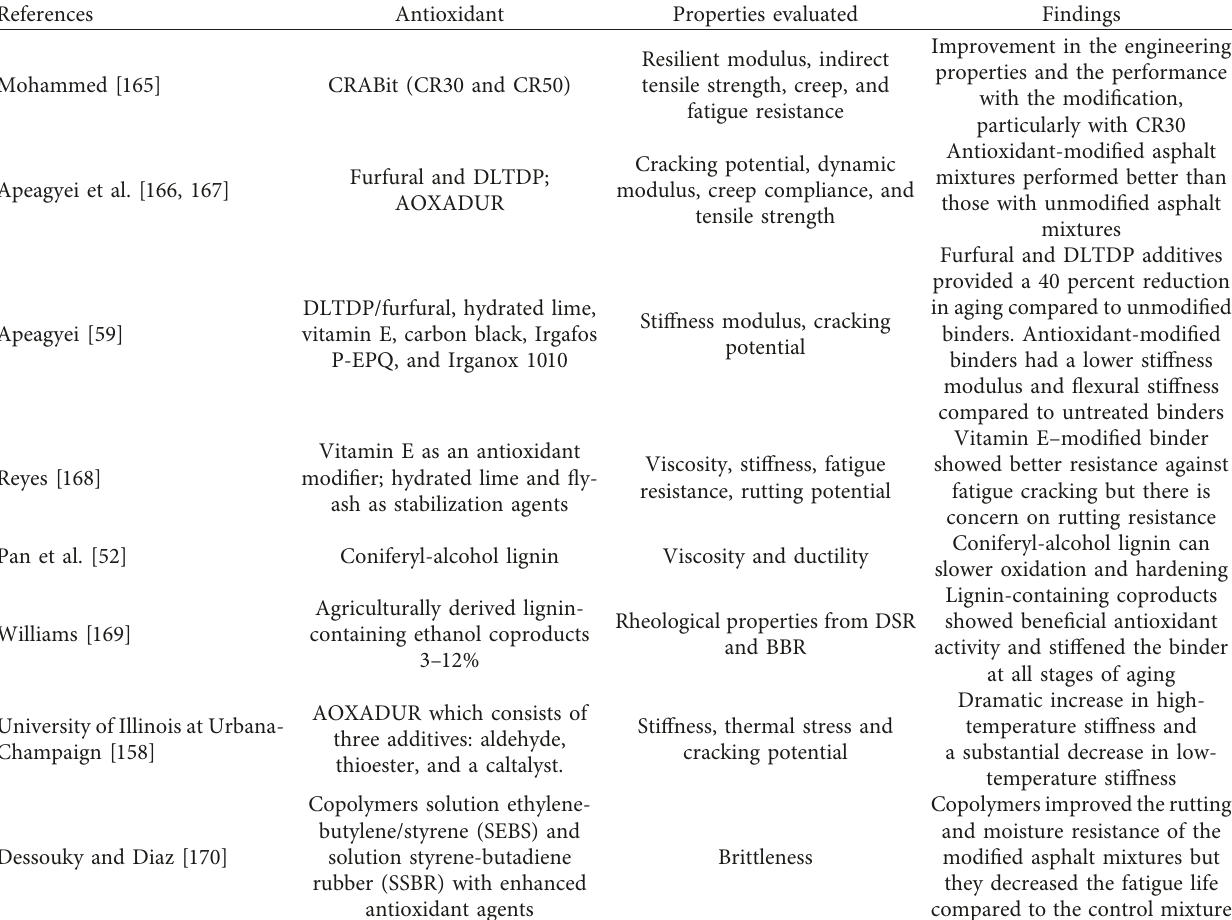
Table 5: Studies on antioxidant